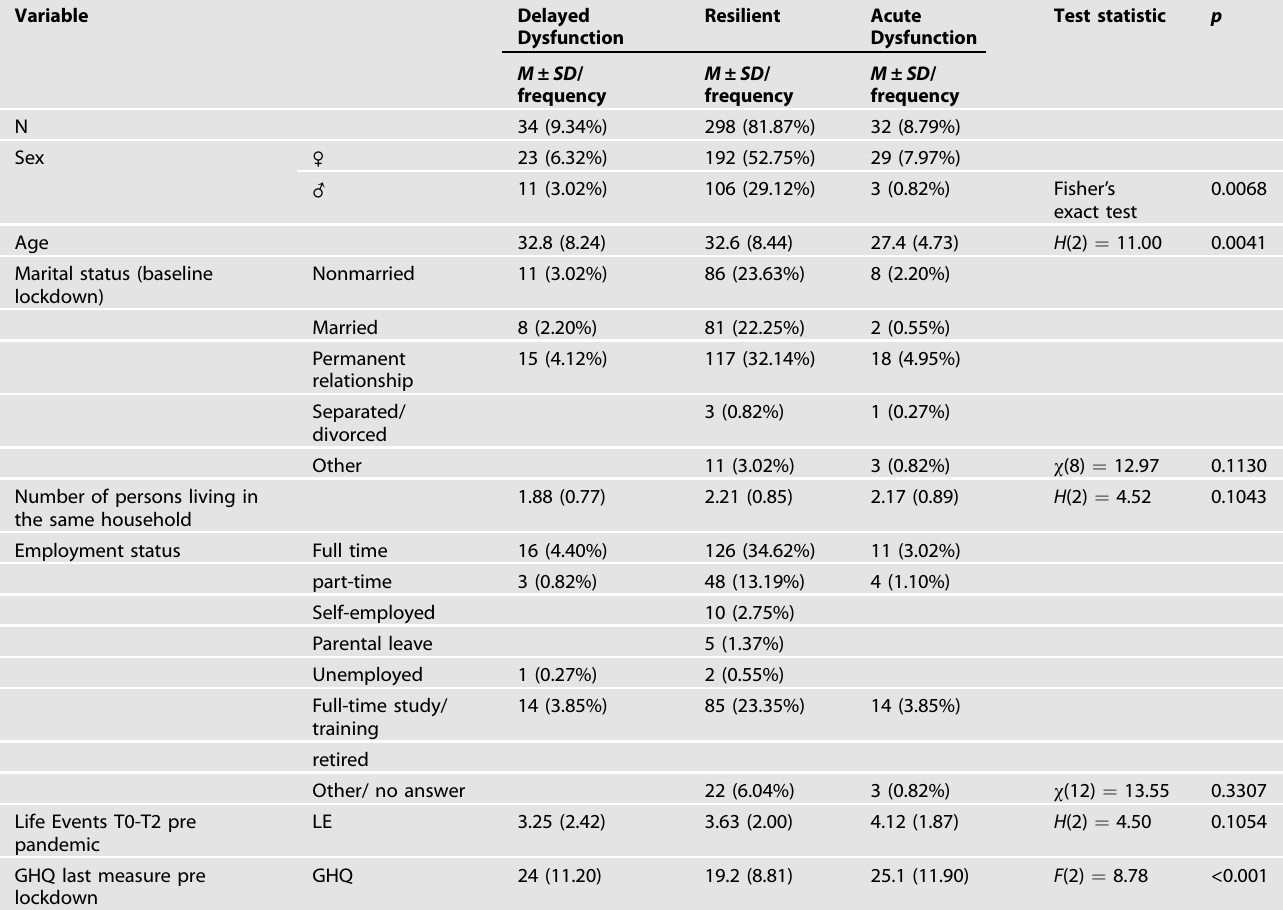
Table 2. Demographics of individuals with PRS data N =